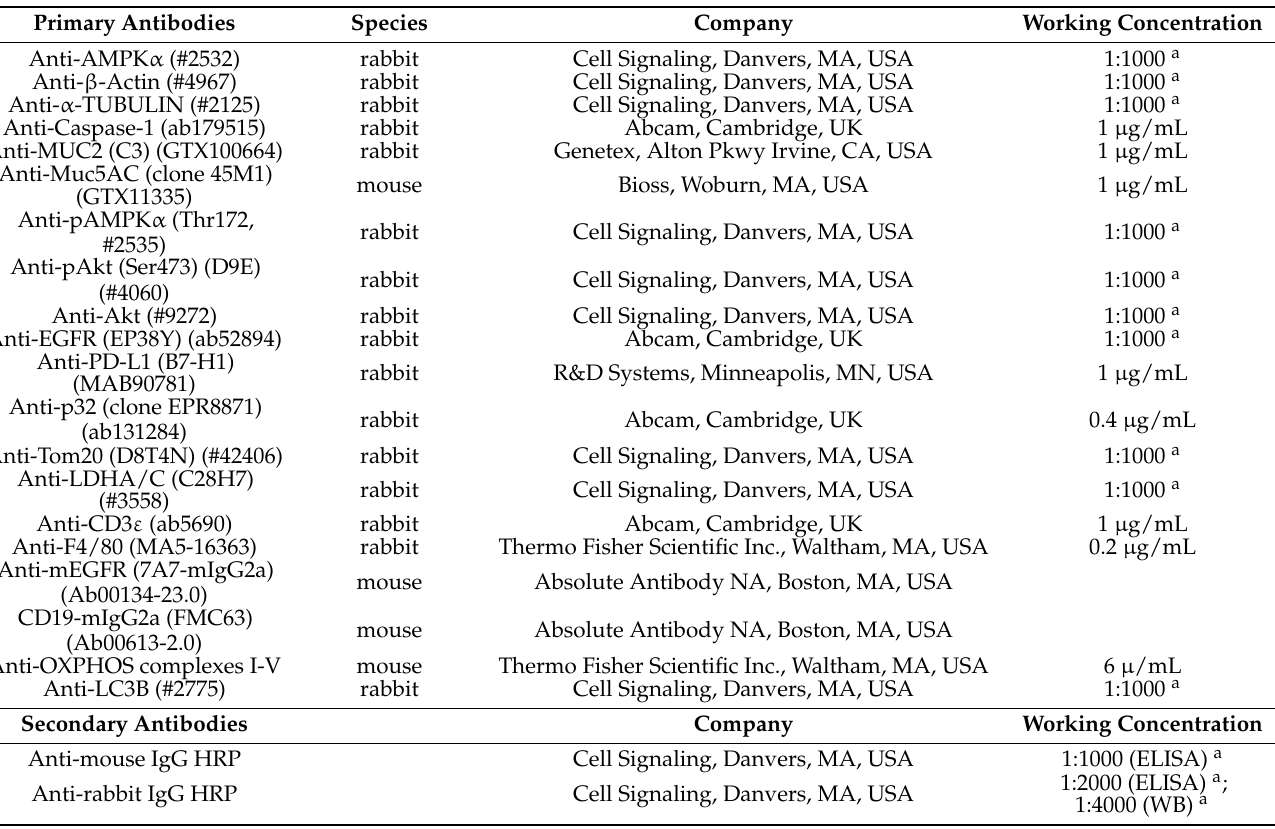
Table 3. Details of applied primary and secondary